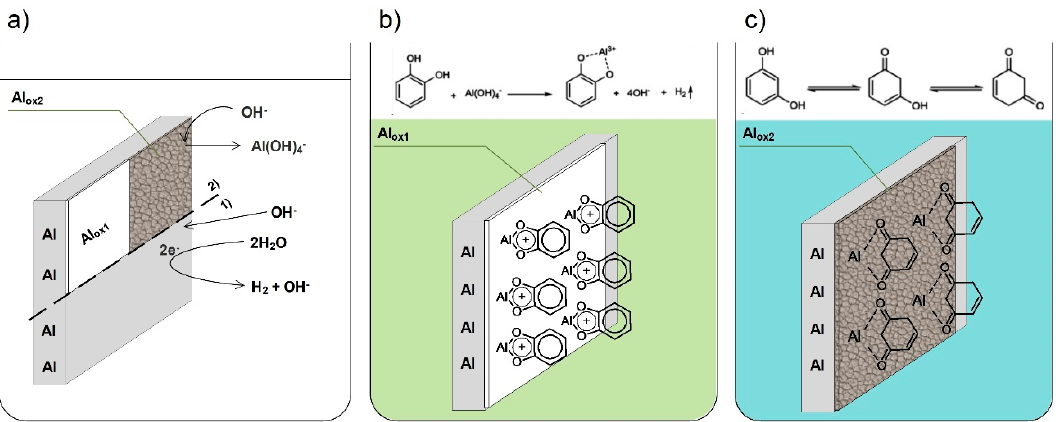
Figure 12. Schematic representation of aluminum corrosion mechanism in aqueous alkaline solutions: ( a ) in absence of corrosion inhibitor and with the addition of ( b ) catechol; ( c ) resorcinol. Phase (1) represents the OH − attack leading to formation Al(OH) 3 , phase (2) describes the interaction between OH − and Al(OH) 3 , leading to the formation of Al(OH) 4 − and a non-stoichiometric insoluble corrosion product